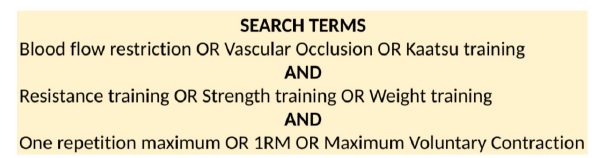
FIGURE 1 | Search terms with alternatives used for literature